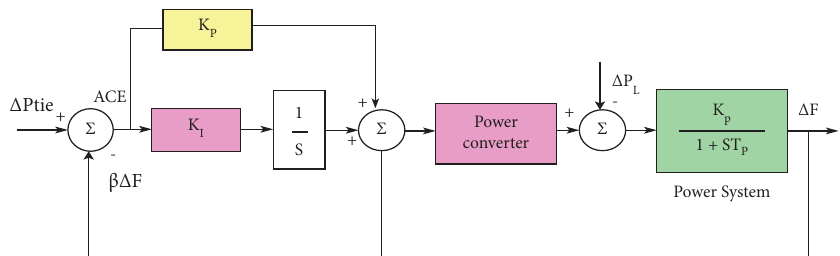
Figure 2: Configuration of the PI control